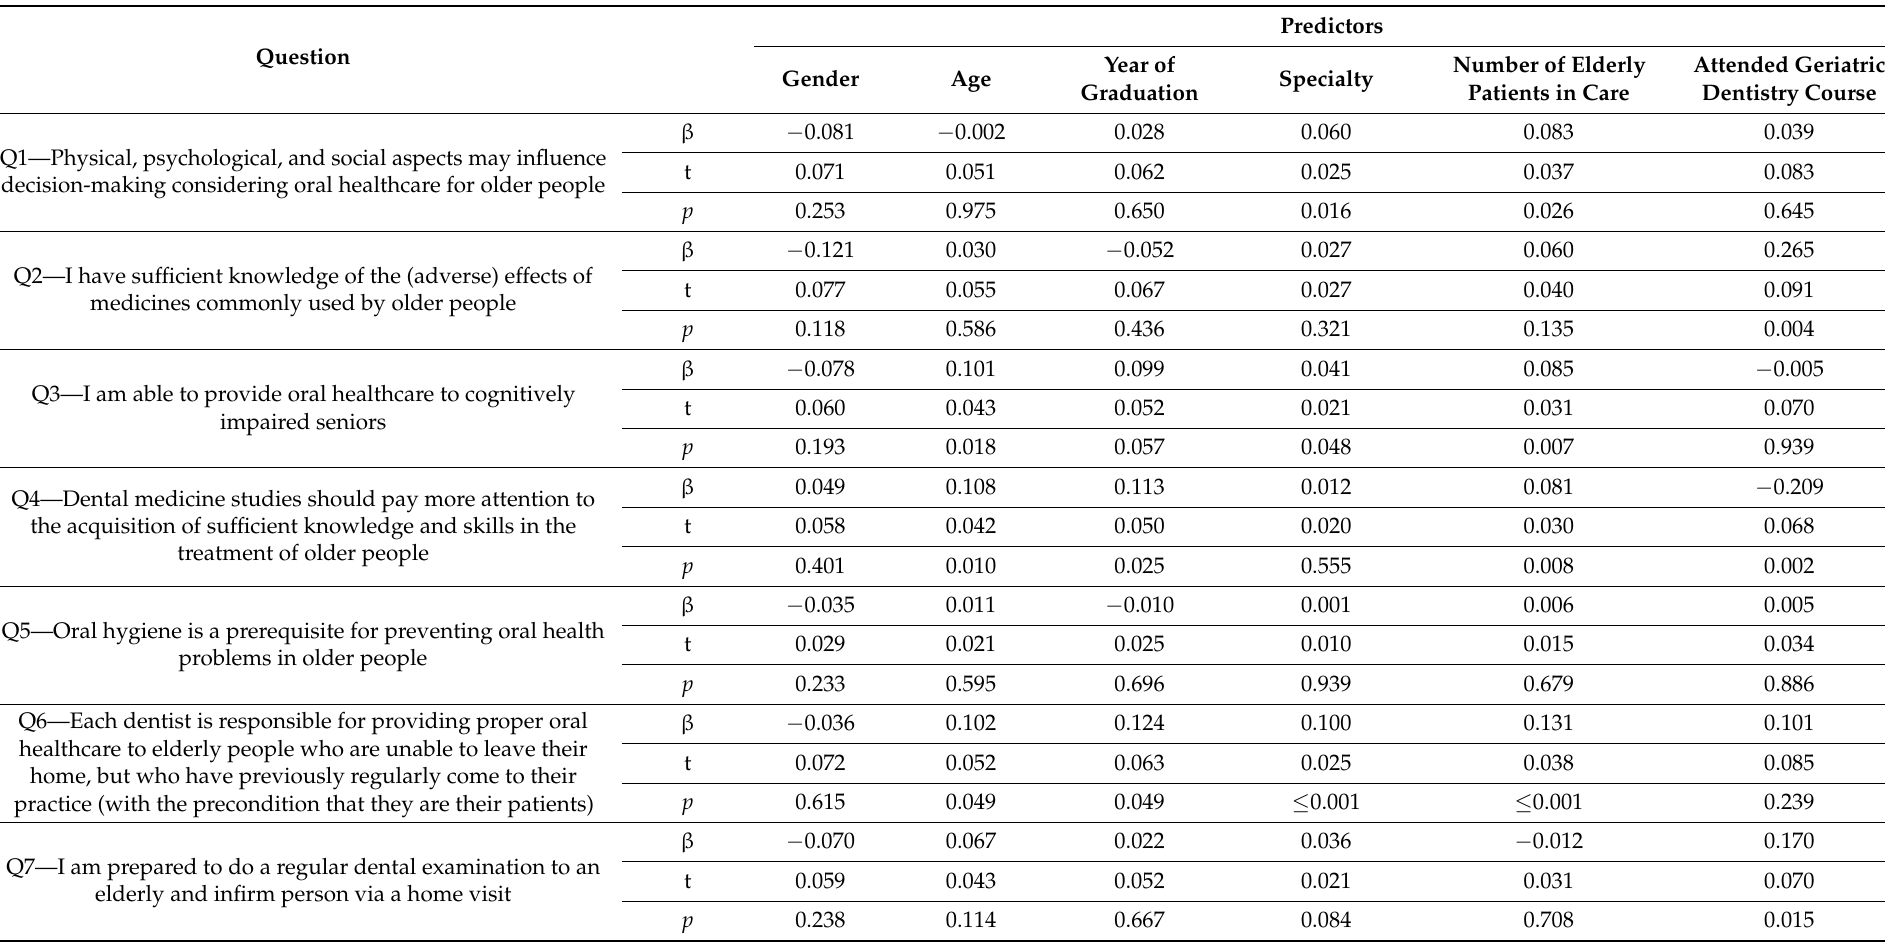
Table 4. Multiple linear regression analysis results for respondents’ opinions on knowledge, attitudes, and barriers in providing oral care to older people, depending on their personal and professional data. Question